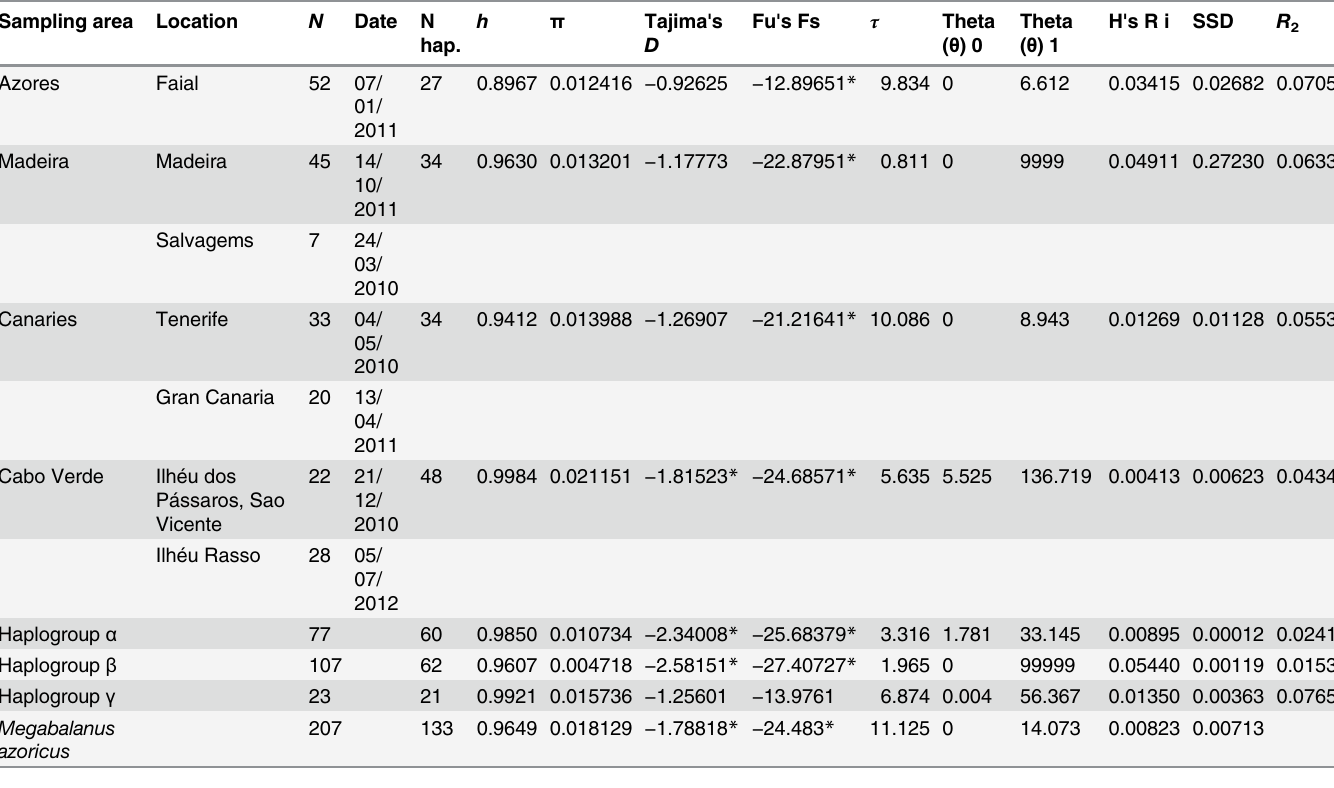
Table 1. Genetic diversity values, mismatch distribution parameters, neutrality, and demographic expansion test for the Megabalanus azoricus populations sampled and haplogroups detected. Sampling area